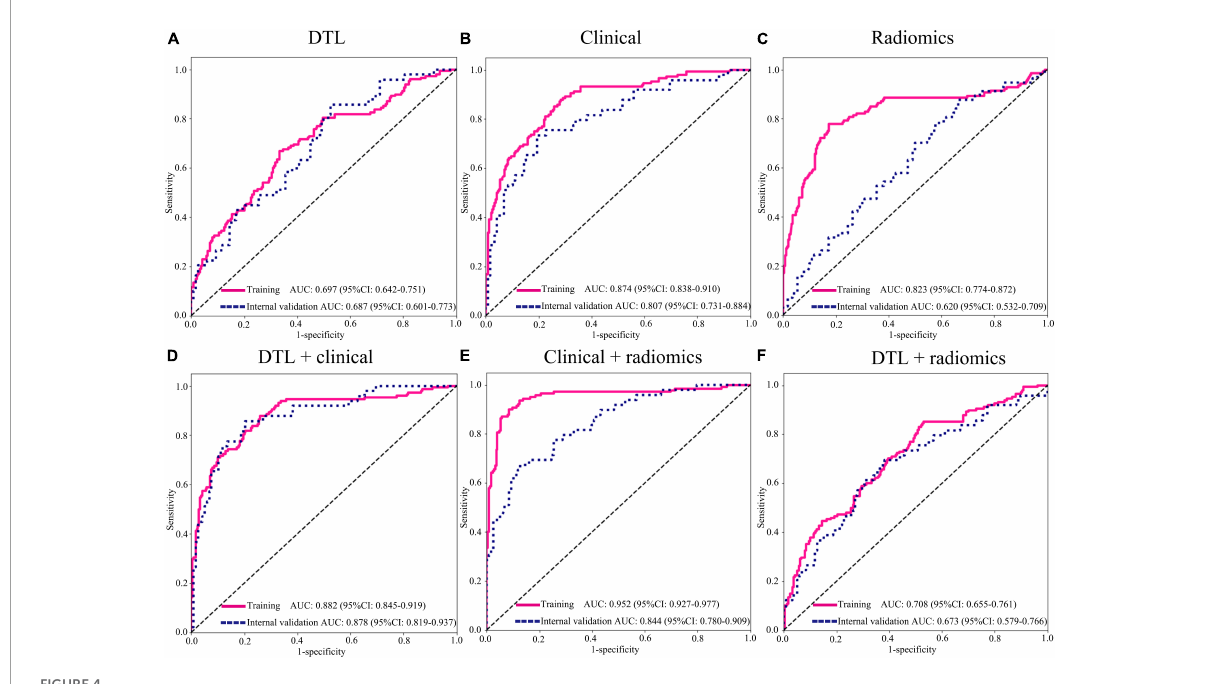
FIGURE4 Area under the curve (AUC) of various groups of feature fusion in the training and internal validation cohorts. (A) DTL features (Resnet152); (B) clinical features; (C) radiomics features; (D) DTL features (Resnet152) + clinical features; (E) clinical + radiomics features; (F) DTL features (Resnet152) + radiomics features. DTL, deep transfer learning.